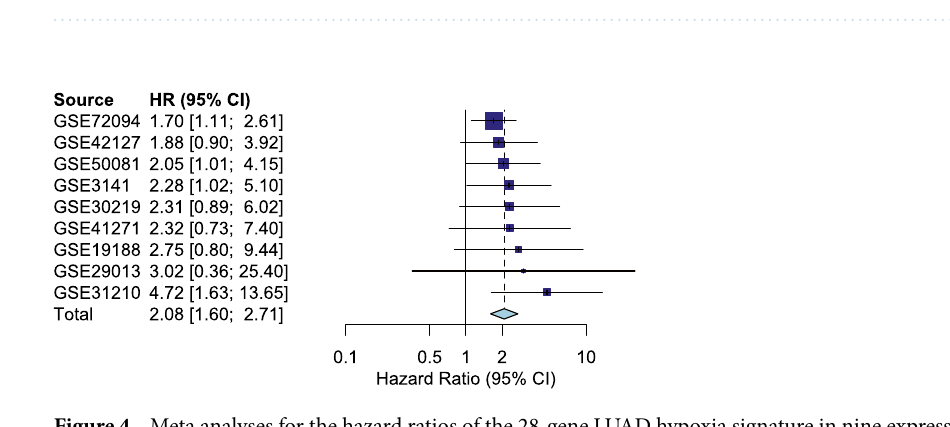
Table 2. Univariable and multivariable analyses for LUAD validation datasets with p < 0.05 in univariate analyses for hypoxia and clinico-pathological variables available. Significant values are in bold.